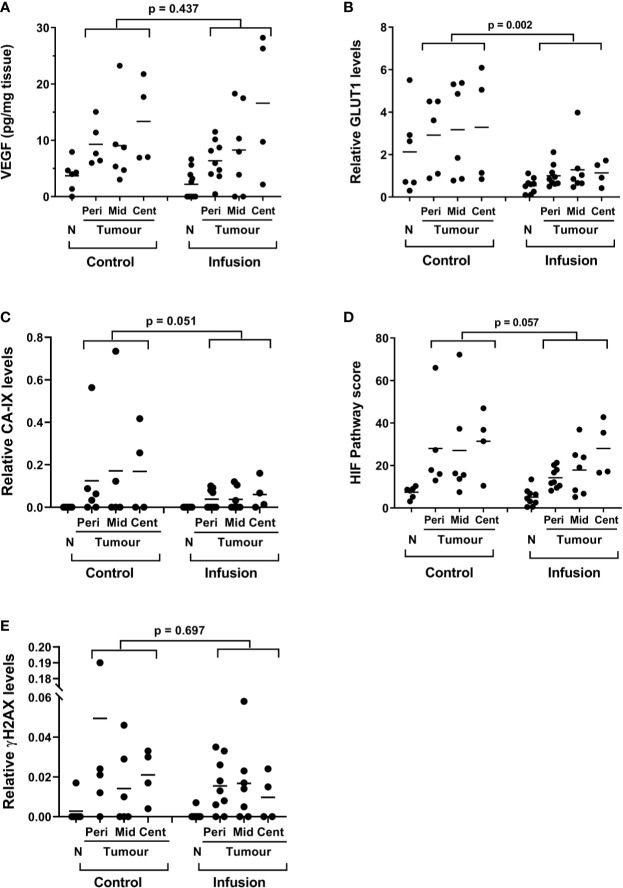
Protein expression associated with the hypoxic response and oxidative stress response in bowel mucosal tissue and in tumor tissue in control and infusion cohorts. Relative levels of (A) VEGF, (B) GLUT1, (C) CA-IX, were monitored in normal mucosal and tumor tissue from each individual. Expression of each protein was elevated in tumor tissue relative to control. Levels were lower in tumor tissue (all tumor regions) from the infusion cohort when compared with the levels in control tumor tissue (unpaired t-test results shown). (D) HIF Pathway score was derived from the combined measurement of the three proteins for each tumor sample. (E) Relative levels of γH2AX in tumor and normal mucosal tissues. Comparative statistics for combined tumor samples from peripheral, mid and central regions of the tumors are shown (unpaired t-tests). In addition, one way ANOVA with fitting for a mixed effects model (Brown-Forsythe and Welch test) indicated a significant increase in the tumor regions from periphery to central for the combined HIF Pathway score (p = 0.02).